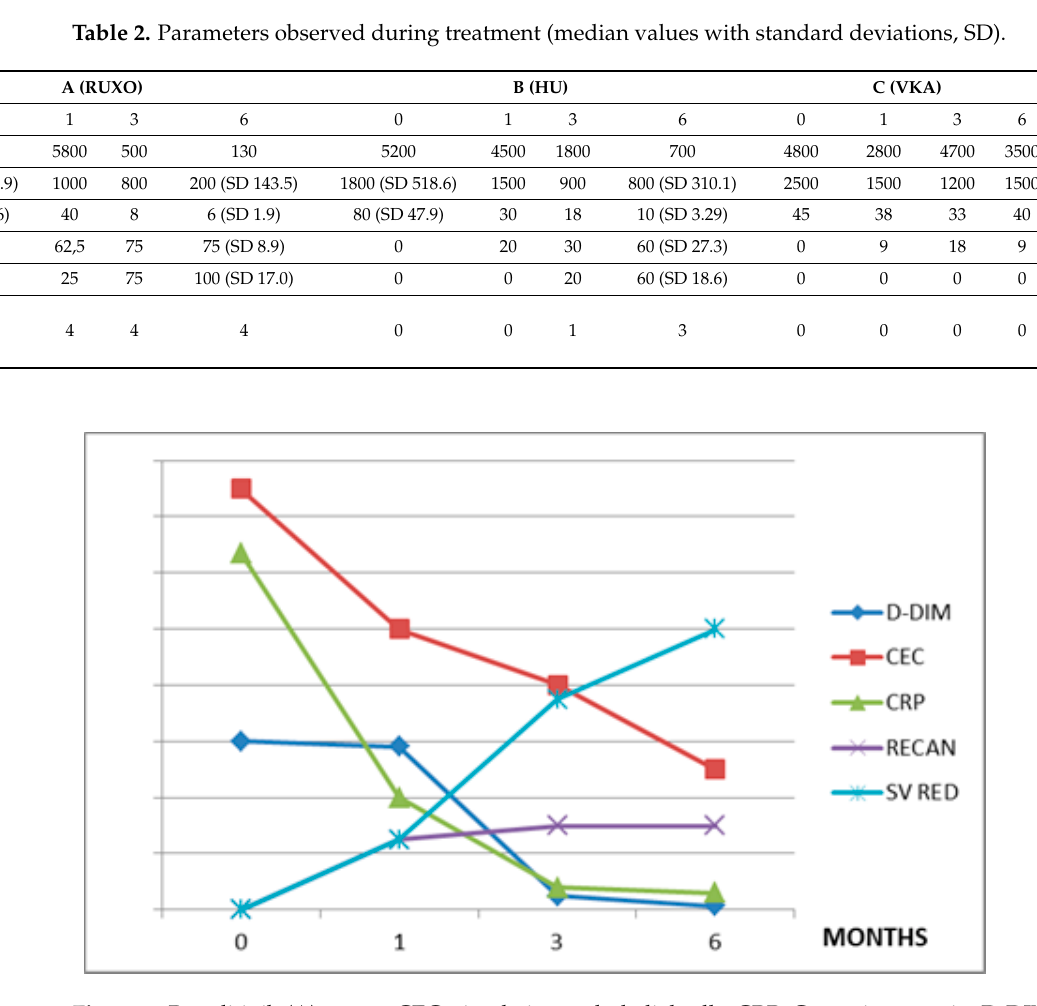
Figure 2. Hydroxyurea (B) group. CEC: circulating endothelial cells, CRP: C-reactive protein, D- DIM: d-dimers, RECAN: % of recanalization, SV: % of splenic volume reduction. Values on y-axis are in arbitrary measures.